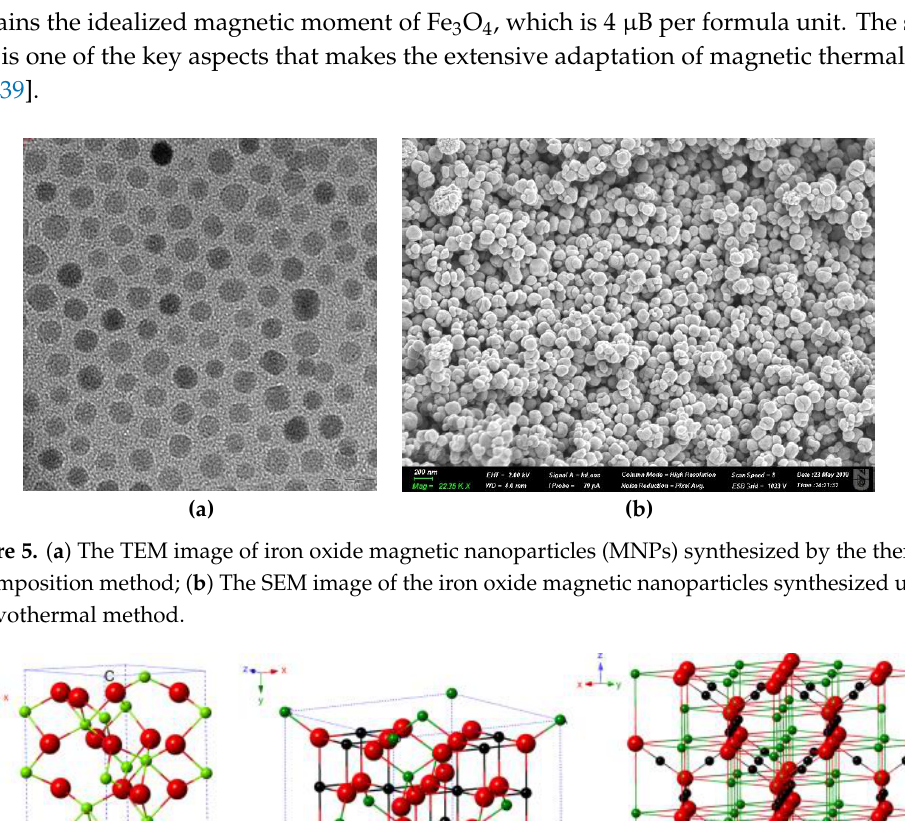
Figure 6. Crystal structure and crystallographic data of the hematite( a ), magnetite ( b ), and maghemite ( c ) (the black ball is Fe 2+ , the green ball is Fe 3+ , and the red ball is O 2 . [Reproduced from [38], with permission by license CC BY 3.0, Copyright 2015].